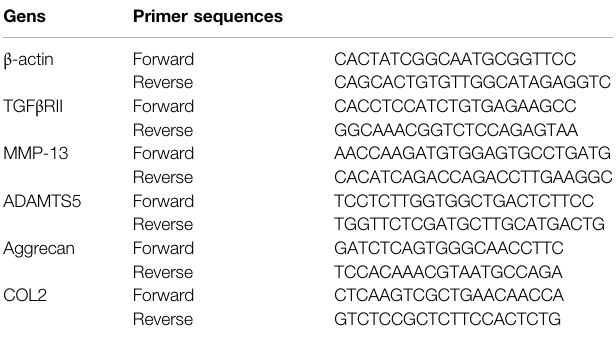
TABLE 2 | Primer sequences for quantitative